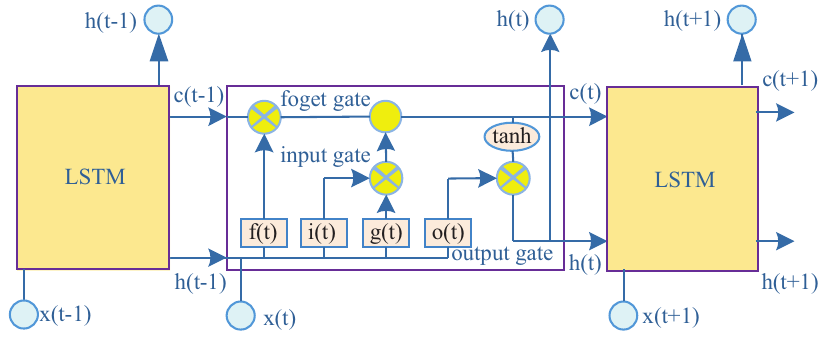
Figure 5. Long short-term memory (LSTM) cell architecture.